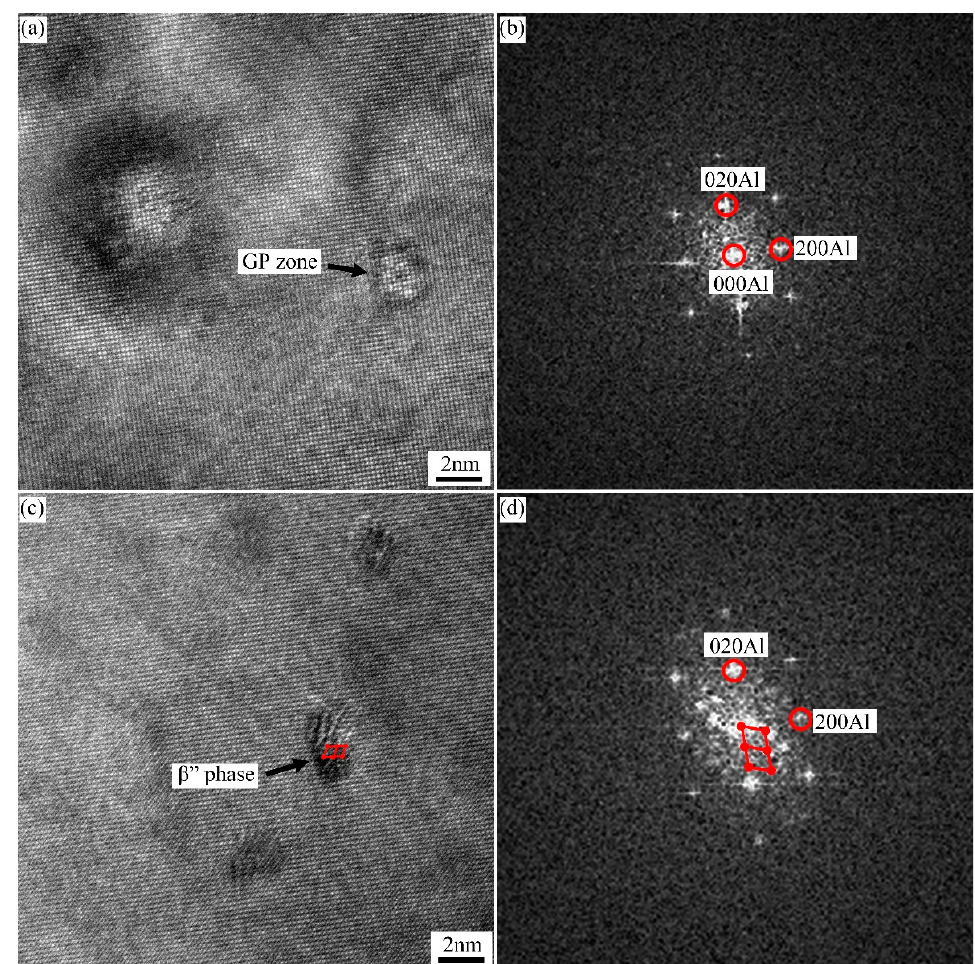
Figure 8. HRTEM images and corresponding FFT patterns of the precipitates marked with the arrows in Figure 7: ( a , b ) GP zone and ( c , d ) β″ precipitates.